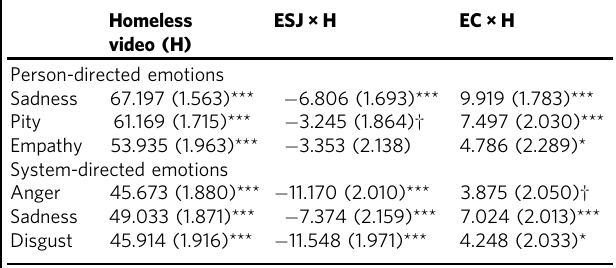
Table 1 Person- and system-directed emotions as a function of economic system justi fi cation (ESJ) and video type (homeless vs. control) in Study 1.